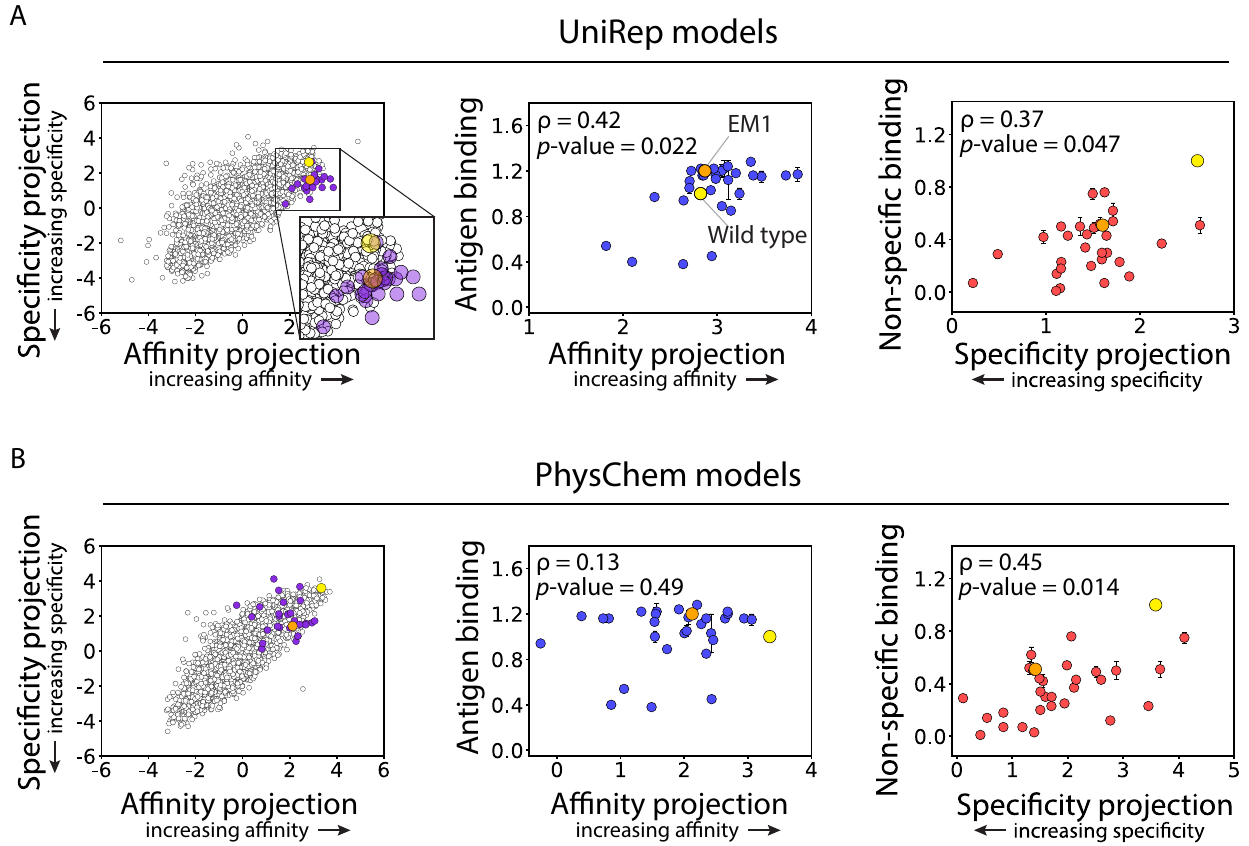
Fig. 5 Models trained with deep learning features generalize to novel mutational space. Models trained using ( A ) deep learning (UniRep) and ( B ) physicochemical (PhysChem) features were used to evaluate the Pareto frontier. ( A , left panel) A panel of 29 antibody variants with novel CDR mutations (not sampled in the original library) were designed along and beyond the Pareto frontier using the model trained with UniRep features. The predictions were limited to evolutionary conserved mutations with Blosum62 scores ≥ 0. ( B , left panel) The designed antibody mutants using the UniRep models led to different distributions relative to the Pareto frontier predicted using the PhysChem models. ( A , middle and right panels) Comparison of UniRep model predictions and experimental measurements of antigen (middle panel, HGFR, 1 nM) and non-speci fi c (right panel, ovalbumin, 0.1 mg/mL) binding for soluble IgGs. ( B , middle and right panels) Comparison of PhysChem model predictions and experimental measurements of antigen (middle panel, HGFR, 1 nM) and non-speci fi c (right panel, ovalbumin, 0.1 mg/mL) binding for soluble IgGs. In ( A ) and ( B ), the experimental measurements are averages of three independent experiments, and the error bars are standard deviations. Independent two-sided t -tests were performed to determine signi fi